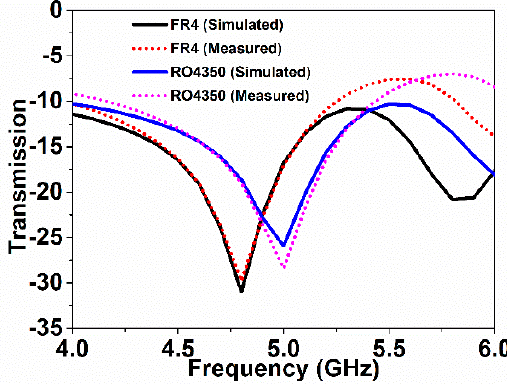
Figure 9. Transmission responses with FR4 and Rogers RO4350 over-layers.